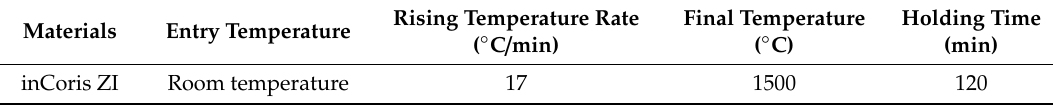
Table 2. Firing parameter for zirconia